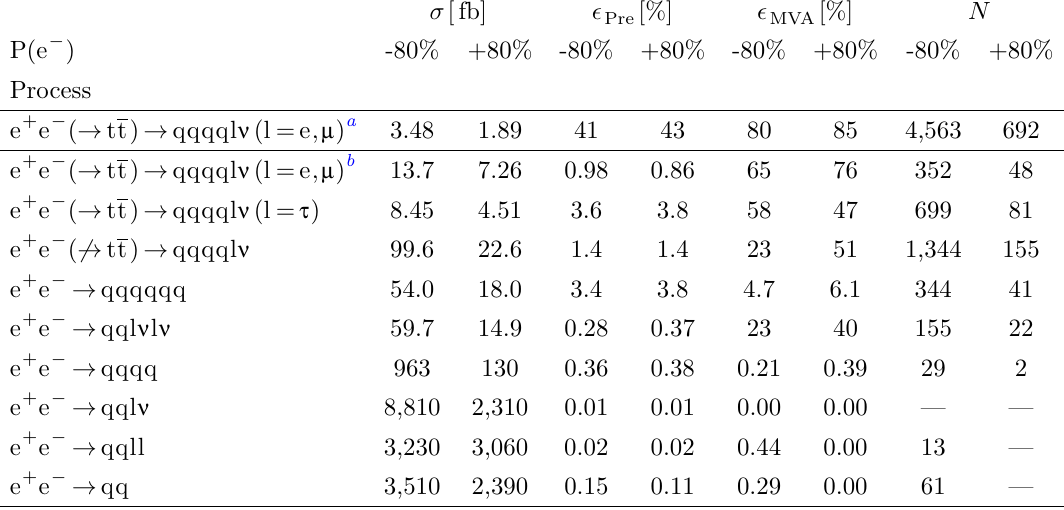
p s = 3 TeV, assuming 4 : 0 ab (cid:0) 1 p s 0 (cid:21) 2 : 6 TeV. The fractional